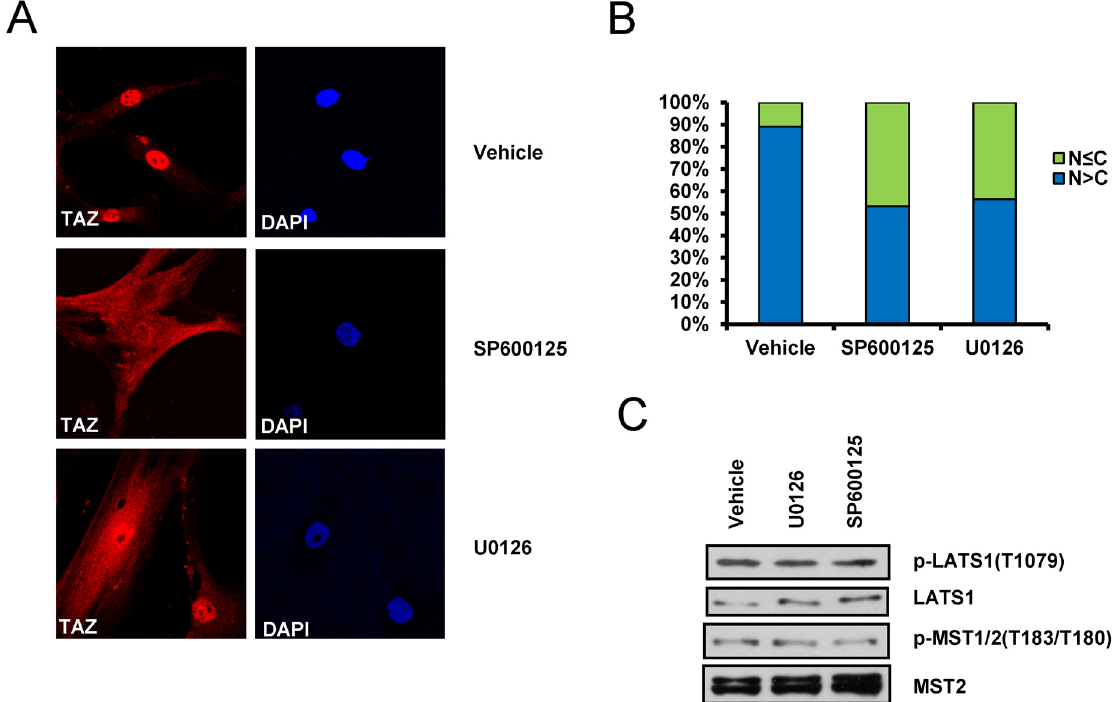
Fig 5. Inhibition of the ERK or JNK signaling pathway induces TAZ cytoplasmic localization on stiff hydrogels. (A) hMSCs on a 4.47 kPa hydrogel were treated with 10 μ M U0126 or 10 μ M SP600125. After 12 h of treatment, cells were subjected to immunostaining with an anti-TAZ antibody. The red fluorescence signal shows the location of TAZ, and DAPI was used to stain the nuclei. The results show that even in cells on a stiff matrix, TAZ is localized evenly to the cytoplasm and nucleus following ERK or JNK inhibition. (B) Approximately 100 cells in panel (A) were counted, and TAZ localization was analyzed in these cells. The counting procedure was done using the Image J program. The number of cells that showed an even cytoplasmic-nuclear or cytoplasm-dominant TAZ localization was higher in the presence of an ERK or JNK inhibitor than in the absence of either inhibitor. (C) Cell lysates in panel (A) were prepared, and the activity of the Hippo signaling pathway components LATS and MST kinase was analyzed by immunoblotting. The phosphorylation status of LATS and MST kinase was analyzed with p-LATS1 and p-MST1/2 antibodies, respectively. Total LATS1 and MST2 levels were detected as a loading